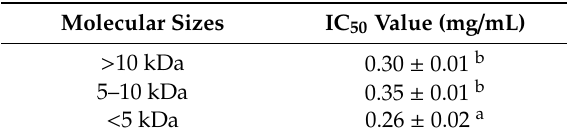
Table 2. Peroxyl radical scavenging activities of di ff erent molecular weight fractions from Alcalase hydrolysate of velvet